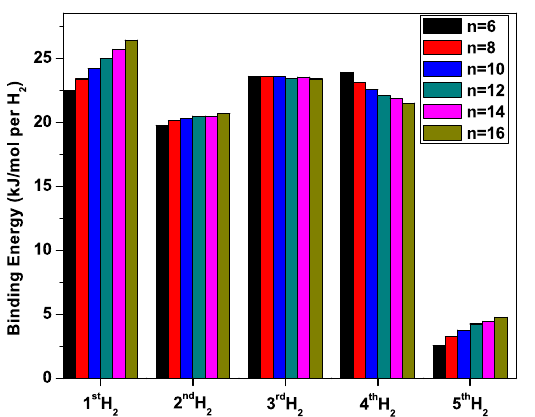
Figure 8. Binding energy of the y th H 2 molecule ( y = 1–5) on Li 2 B n ( n = 6, 8, … , and 16), obtained with TAO-